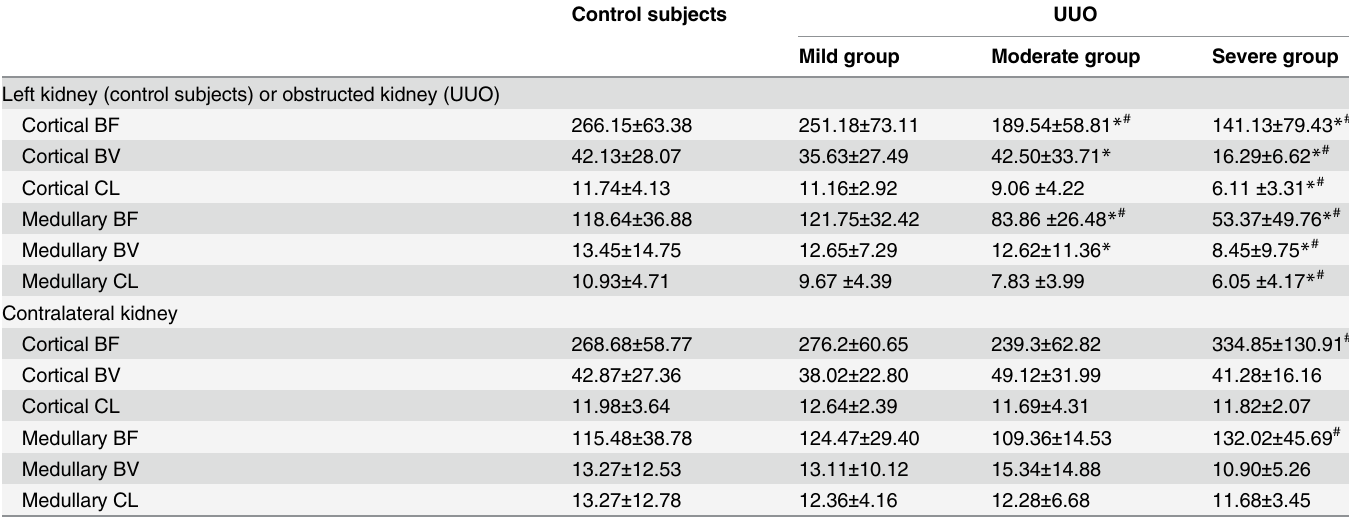
Table 1. The mean cortical and medullary perfusion parameters of bilateral kidneys in control subjects and UUO patients. Control